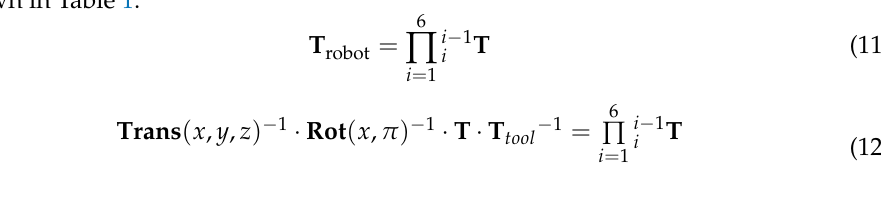
T robot , which represents the pose of the UR5 robot, is obtained via Equation (11). The UR5 robot’s pose should satisfy Equation (12), and the D-H parameters of the UR5 robot are shown in Table 1.